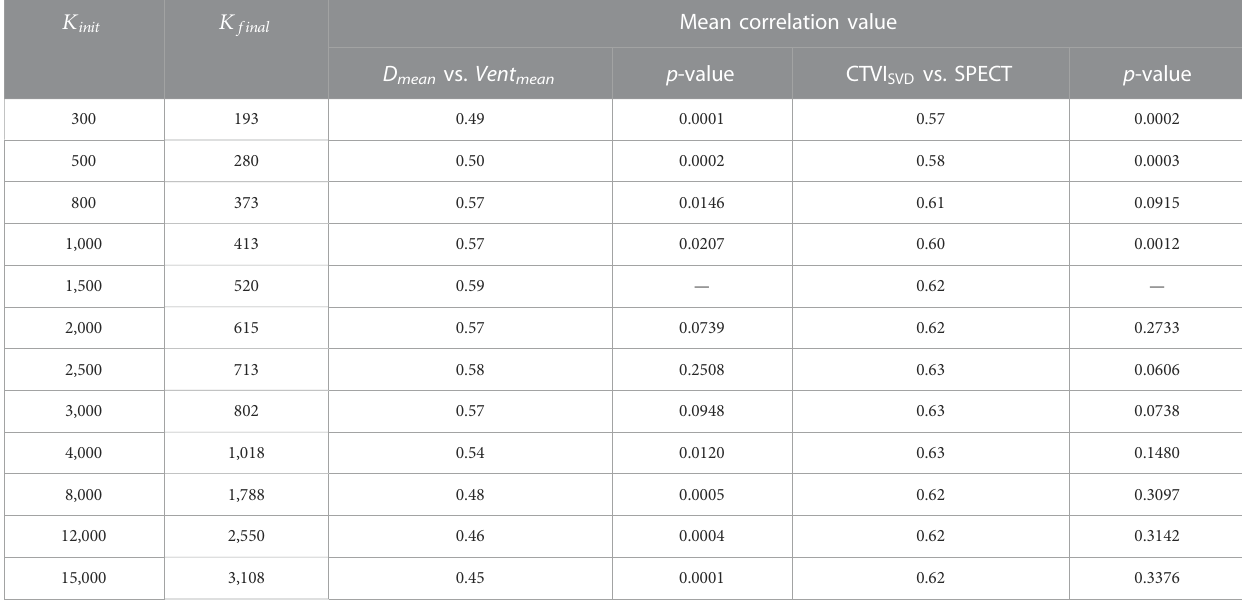
TABLE 1Thein fl uence of the differentnumbersof the super-voxel. K init meansthe initial setting ofthe super-voxel number forthe CT image,and K final meansthe fi nal extracted super-voxel number in the lung volume. The mean correlation value is the mean Spearman correlation value of all the patients. D mean is the mean density of the super-voxel, and Vent mean is the mean ventilation value of the super-voxel. The p -values are obtained from the paired-samples t -test of the K init of other value with the K init of 1,500. K